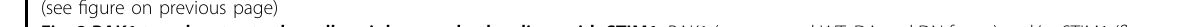
of STIM1 was expressed as a GST fusion protein in E. coli and incubated with puri fi ed PAK1 protein overnight at 4 ° C after puri fi cation, followed by washing and immuno- blotting with anti-PAK1 antibody. The results of this assay revealed that STIM1 interacted with puri fi ed PAK1 as a GST fusion protein, whereas the GST protein did not pull down the PAK1 protein (Fig. 1c, d).